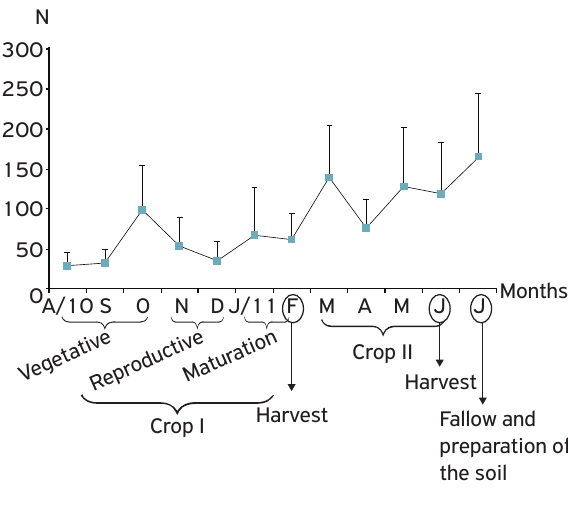
Figure 2. Monthly (August to July) mean abundance of granivorous birds in the irrigated rice fields, Itajaí, Santa Catarina. The estimated loss of rice due to the joint action of S. superciliaris and S.